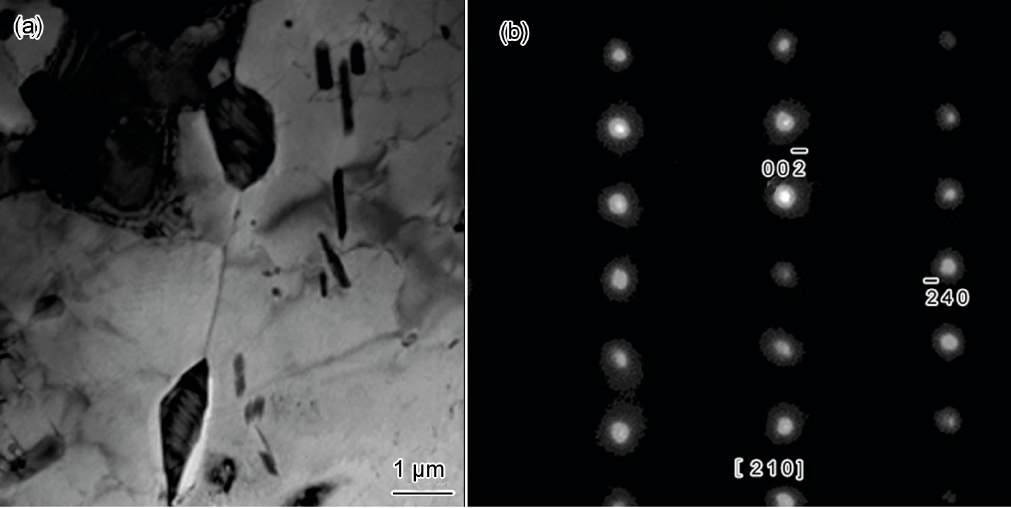
Figure 5. Micrographs of particles within bainite: ( a ) 680-2, ( b ) 680-100, ( c ) SAED pattern, and ( d ) EDX.